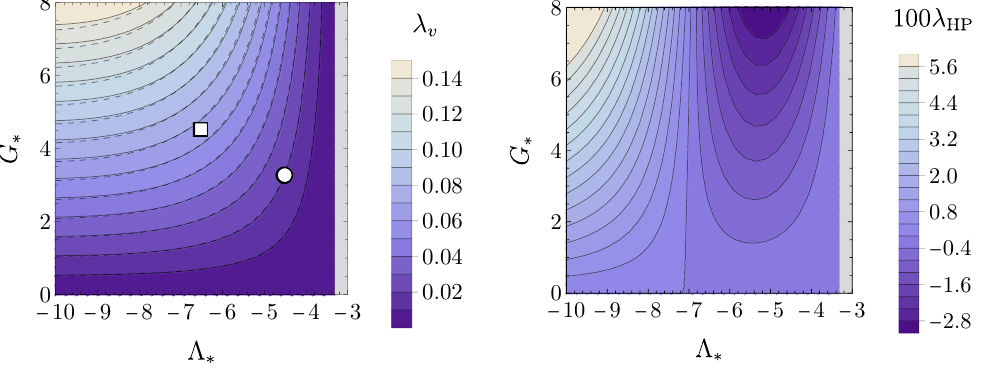
Figure 4 . Contours for the fixed-point value λ v ∗ ( λ HP ) of the visible quartic coupling on the left (right) as a function of the gravitational fixed-point values G coupling λ is the representative of the quartic Higgs coupling in our toy model. The dot (square) v marks the position of the gravitational fixed point without (with) a dark sector in an approximation detailed in the main text. In the left plot solid (dashed) contours mark the value with (without) the contributions from a dark